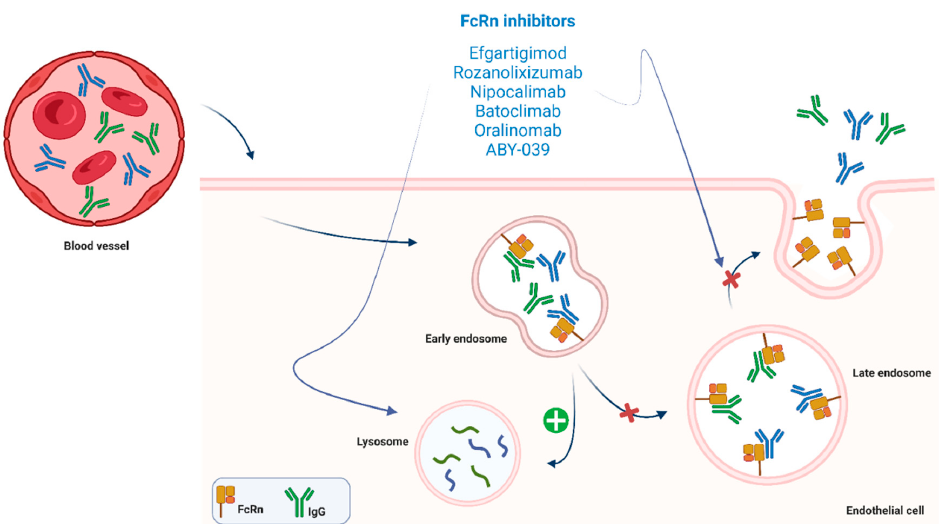
Figure 3. FcRn-targeted drugs exert is mechanism of action by inhibiting FcRn functions. These drugs favor lisosomal pathways activation and inhibit endosomal recycling of IgG. Their actions result in a drastic diminution of pathogenic IgG blood levels.